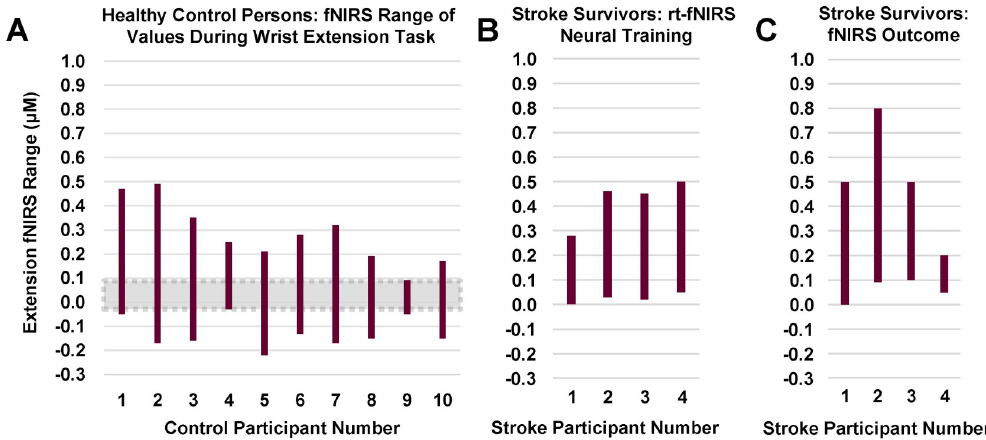
Fig 5. fNIRS: Range of values for ‘active–rest’ hemoglobin concentration during wrist extension task three conditions, all during wrist extension task. Panel A. Healthy controls fNIRS range of values during wrist extension. Panel B. Stroke survivors during rt-fNIRS training for wrist extension. Panel C. Stroke survivors during wrist extension without neural feedback (pre-, post-treatment, follow-up. Key: Each vertical bar shows the range of HbO for a given individual, each of whom are identified on the horizontal axis. For y-axis, oxyhemoglobin concentration values were calculated as the difference between ‘active-rest’ condition. This difference variable is a change in oxyhemoglobin concentration from rest to the active movement state, derived from the fNIRS signal. The above rectangles for each participant represent the range of values for that given participant. � Data for healthy controls and S1 were acquired using Hitachi fNIRS system and data for S2, S3, and S4 were acquired using the NIRx fNIRS